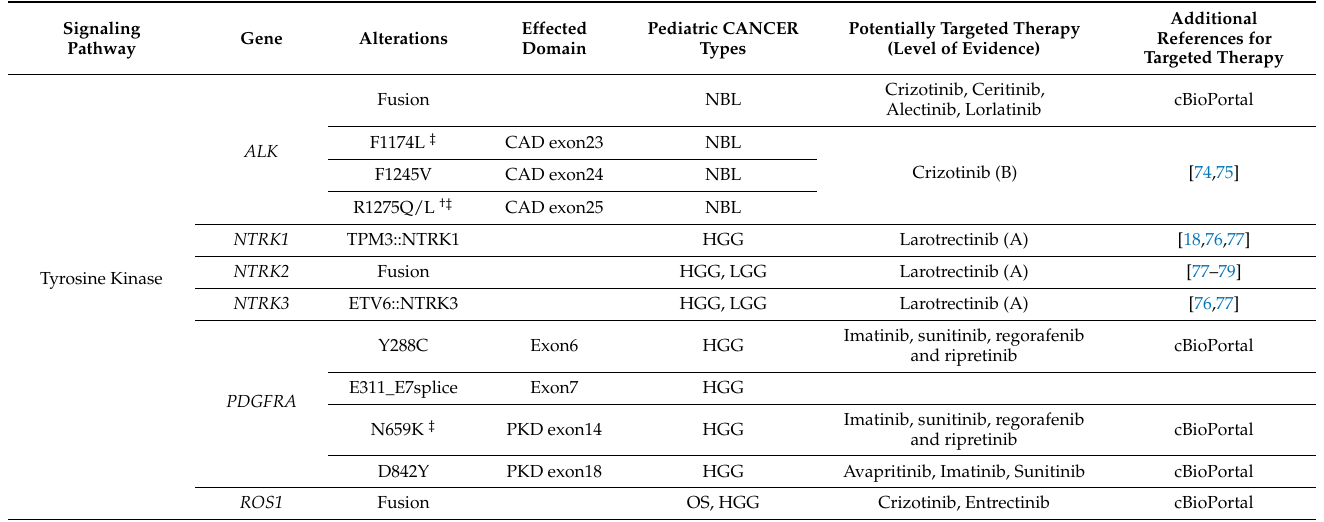
Table 4. Significant genomic alterations of actionable genetic mutations in pediatric solid tumors. Signaling